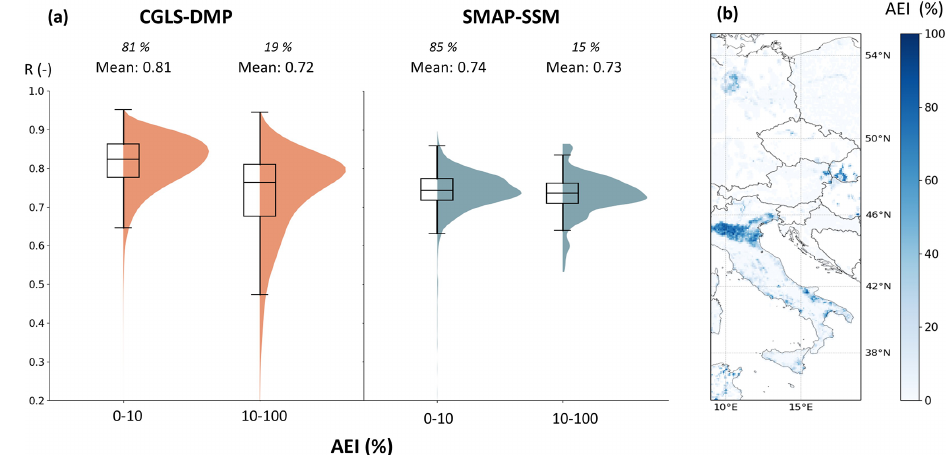
Figure 10. (a) Box plots with a violin curve of temporal R values grouped by the FAO percentage of area equipped for irrigation (AEI). Group 1: 0%–10%, group 2: 10%–100%. The left side is for CGLS-DMP and the right side for SMAP-SSM. The percentage of the total number of pixels for each group and the spatial mean R value are noted at the top of the figure. (b) AEI map over the study